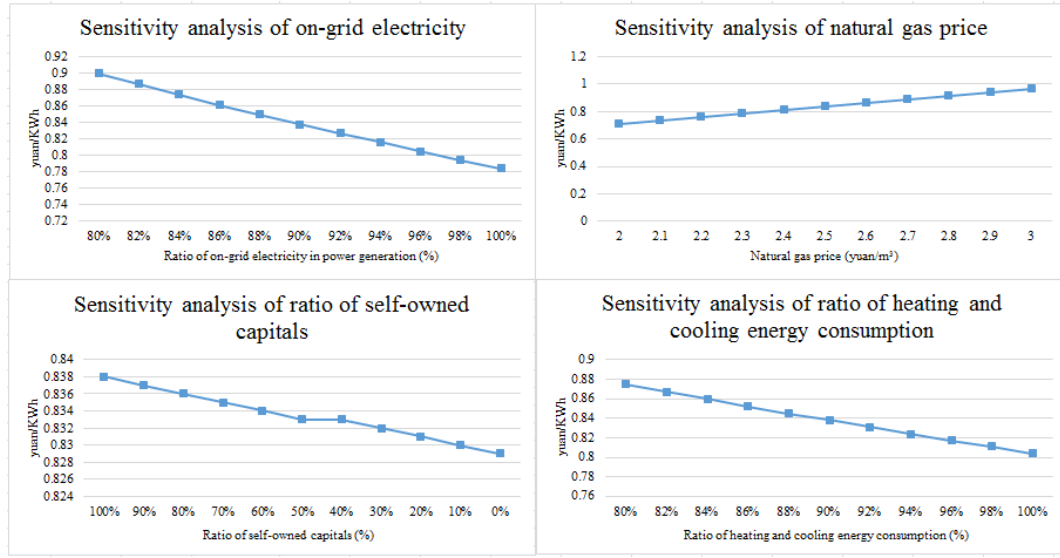
Figure 5. Sensitivity analysis diagrams.